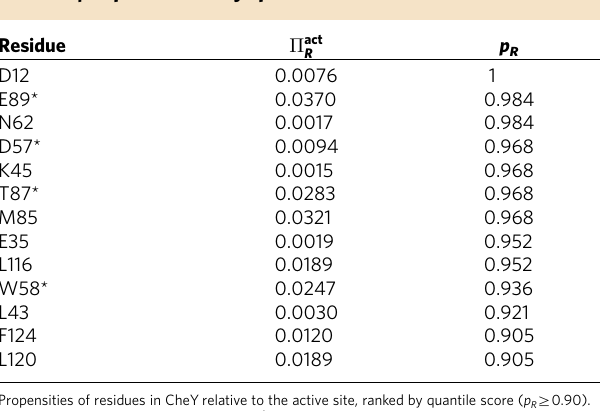
Propensities of residues in CheYrelative to the active site, ranked by quantile score ( p R Z 0.90). The star (*) indicates residues within 3.5Å of the allosteric effector.